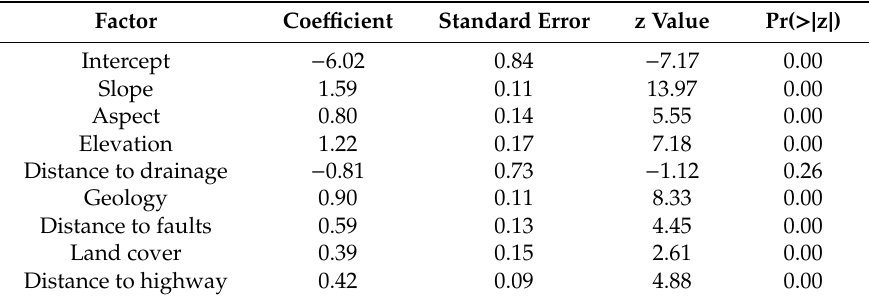
Table 3. Coe ffi cient and test statistics of variables used in logistic regression. Factor Coe ffi